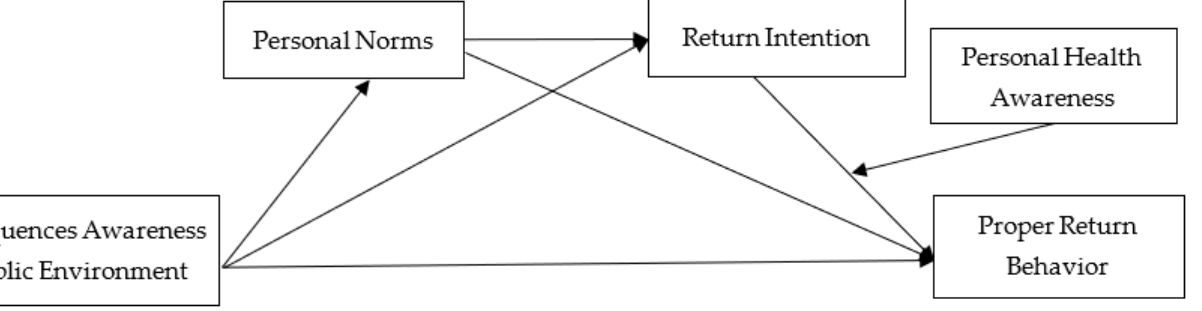
Figure 2. Theoretical research model.